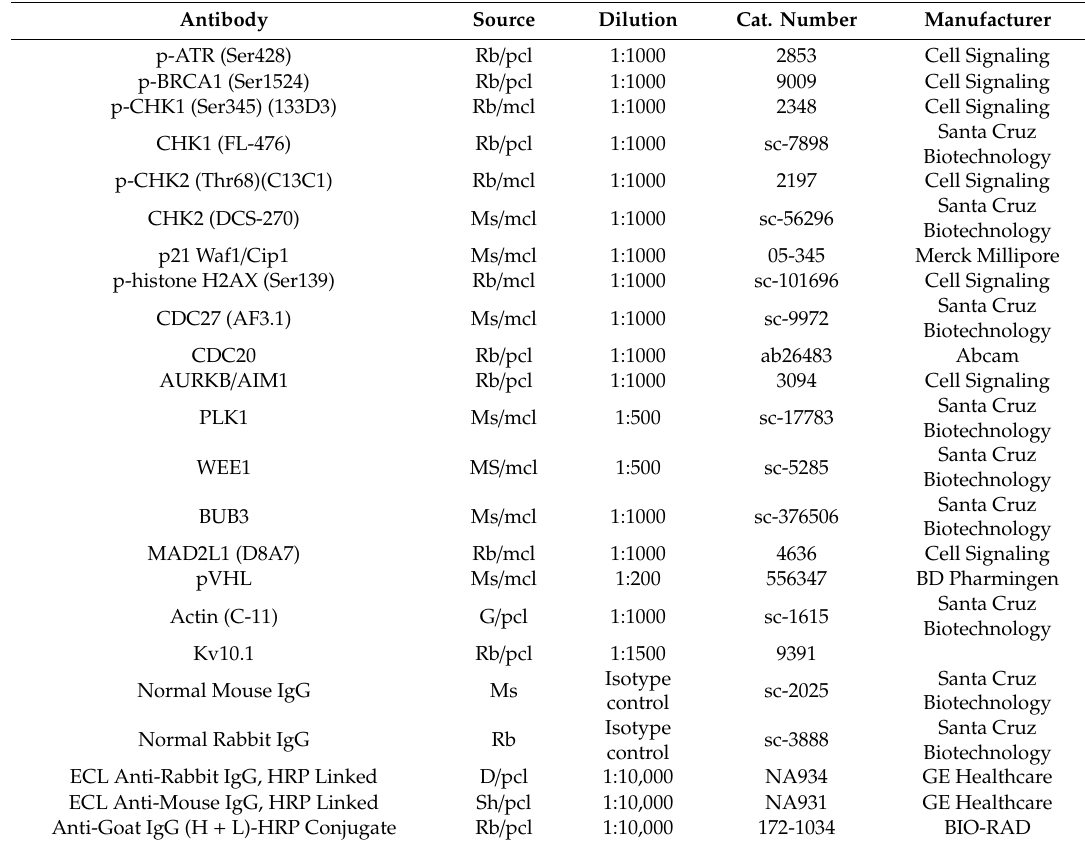
Table 2. List of primary and secondary antibodies used for